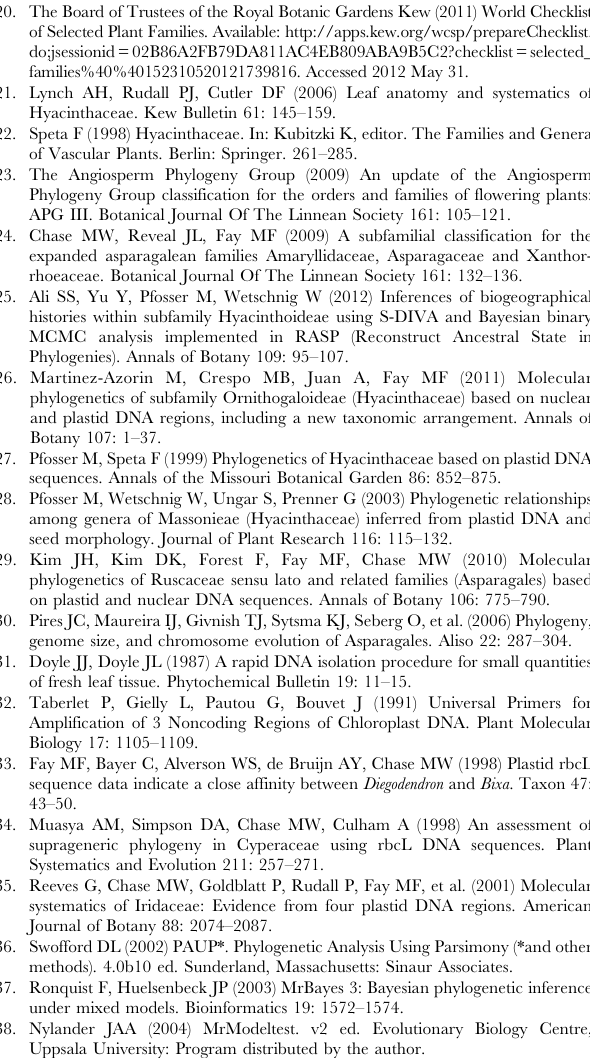
Figure S4 Occurrence of extinction events through time for Hyacinthaceae inferred by Lagrange. The lineage through time plot (shown in red and based on the PL-dated consensus tree) is displayed with an estimation of climatic oscillations in blue (estimated from the variation of O 18 concentration through time [54]). Table S1 Classification and genera of Hyacinthaceae, with generic delimitation, distribution and species numbers.